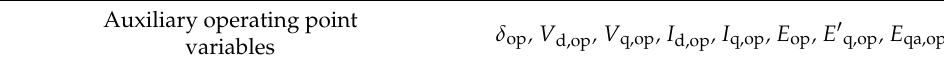
Table 2. Auxiliary operating point variables necessary for calculation of the parameters of the H–P model.